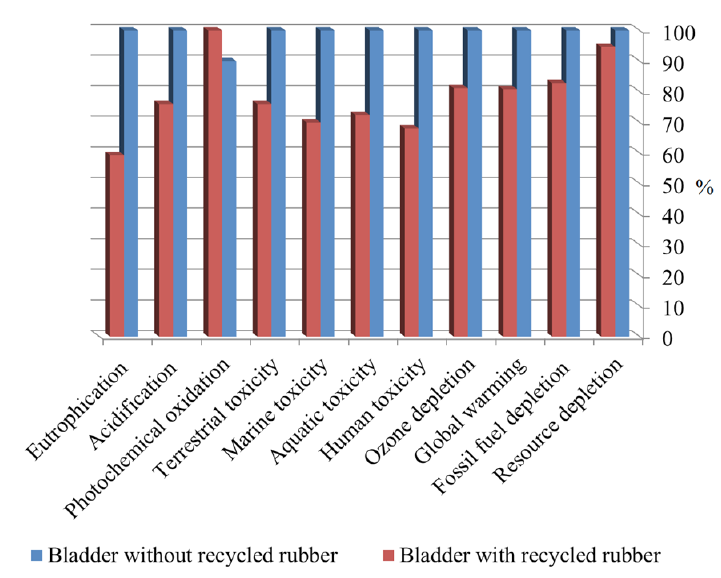
Figure 4. Comparing the environmental impacts of 1 Kg of ball bladder with and without recycled